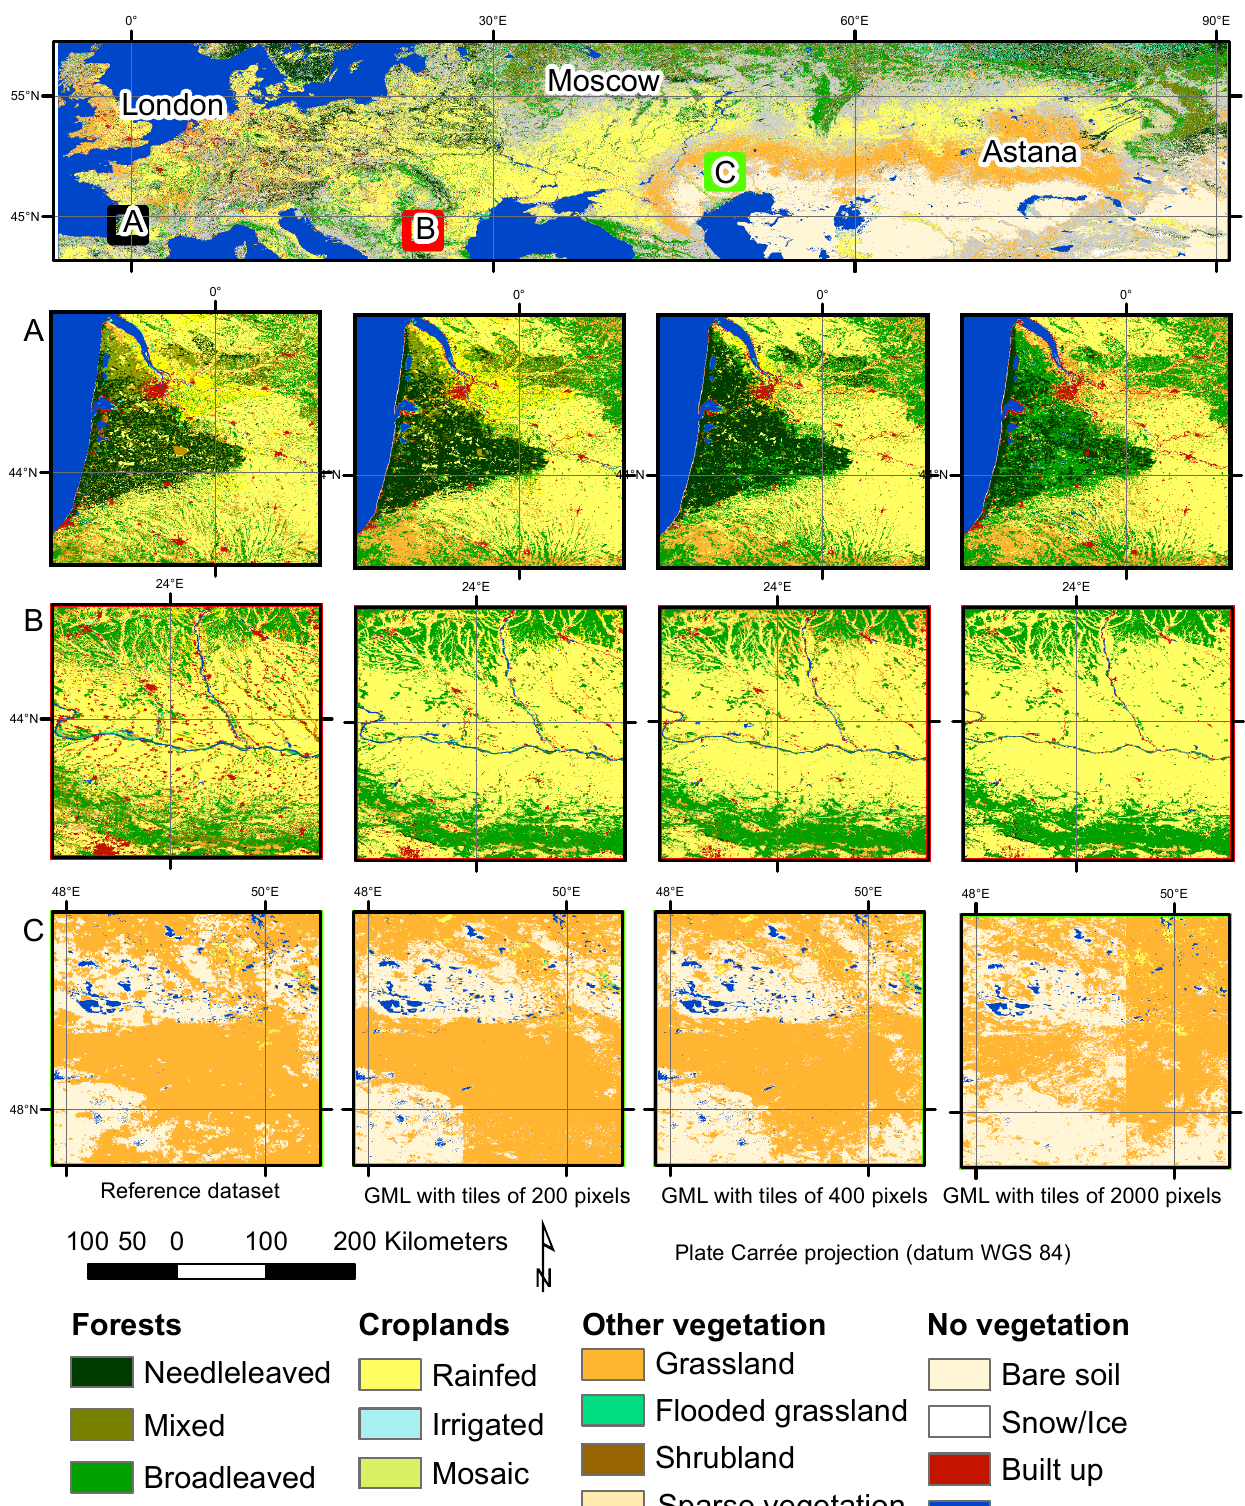
Figure 7. Classification results in Eurasia illustrate three typical issues of the proposed method. ( A ) In the black frame, a large change of forest type is not captured when using small tiles; ( B ) in the red frame, large tiles are unable to capture small cities; ( C ) in the green frame, residual artificial boundaries are visible between two tiles. The grey pixels in the overall view are uncertain based on the a posteriori